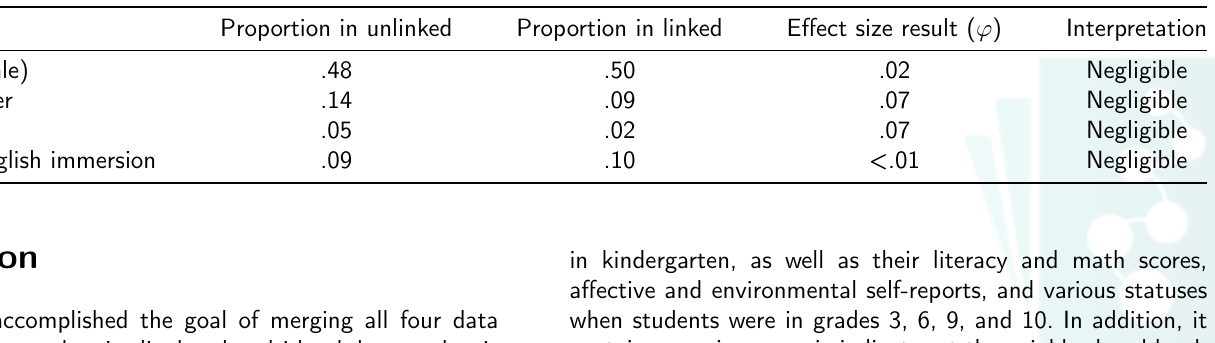
Table 3: Effect sizes ( φ ) of differences in demographic variables between unlinked ( n = 170 , 865) and fully linked ( n = 86 ,